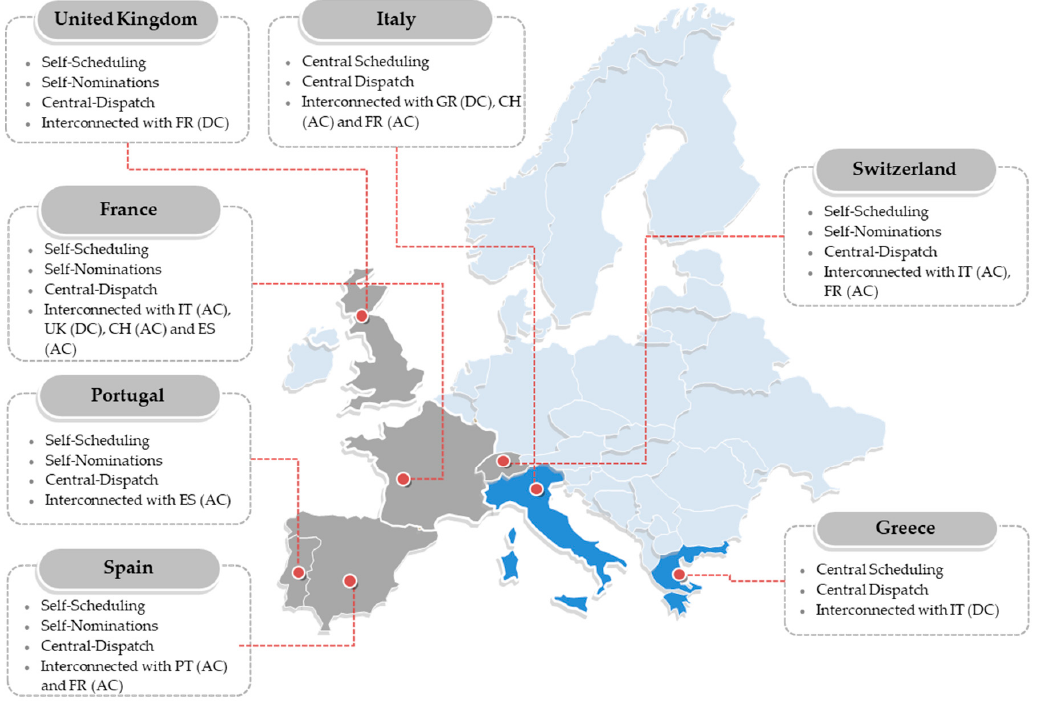
Table 1. Unit capacity in central dispatch markets and Balancing Energy Orders (BEOs) price range in all markets.